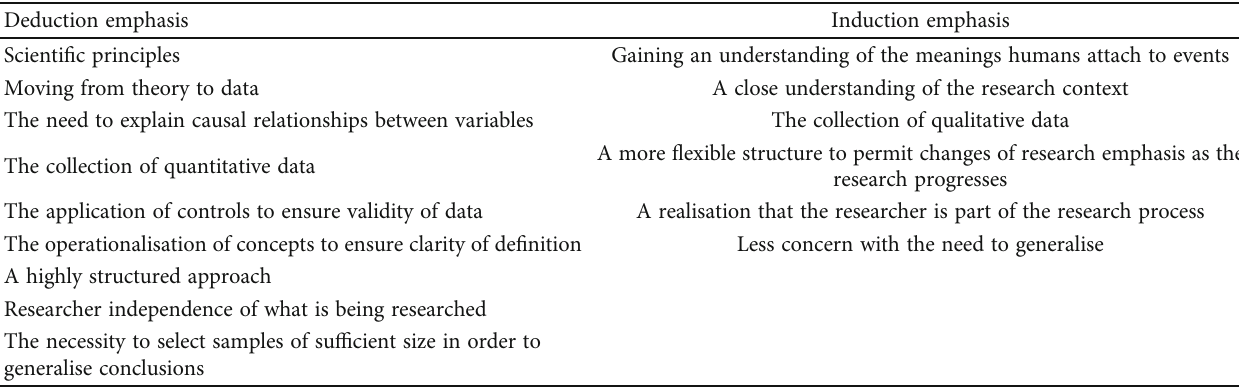
Table 1: Deductive and inductive